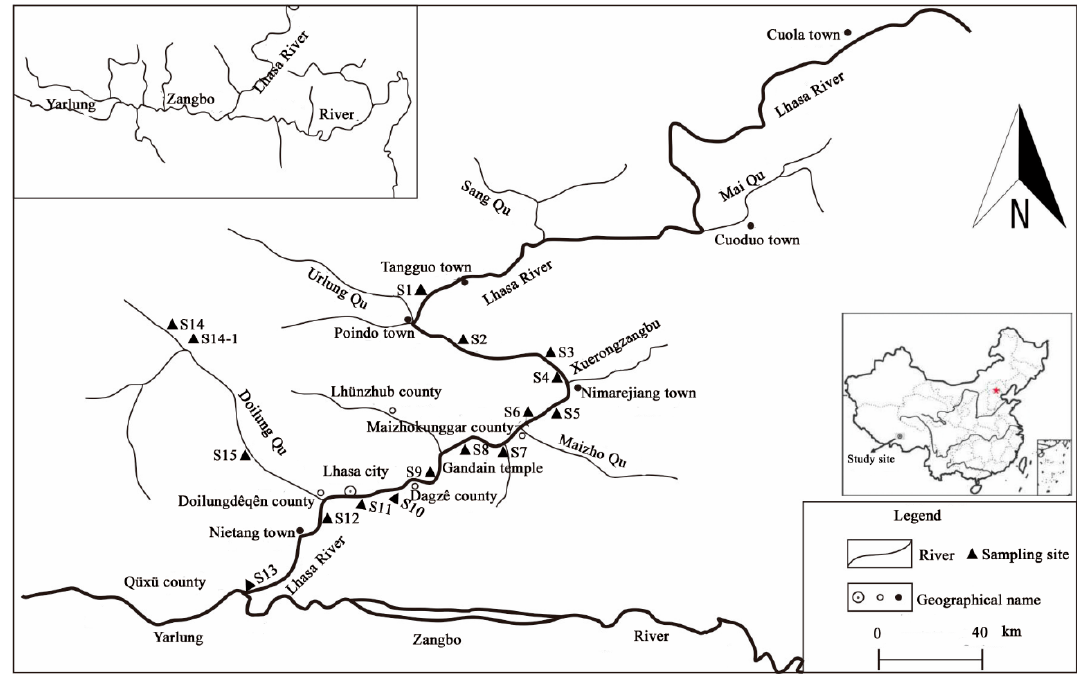
Figure 1. Location of the Lhasa River and the sampling sites.